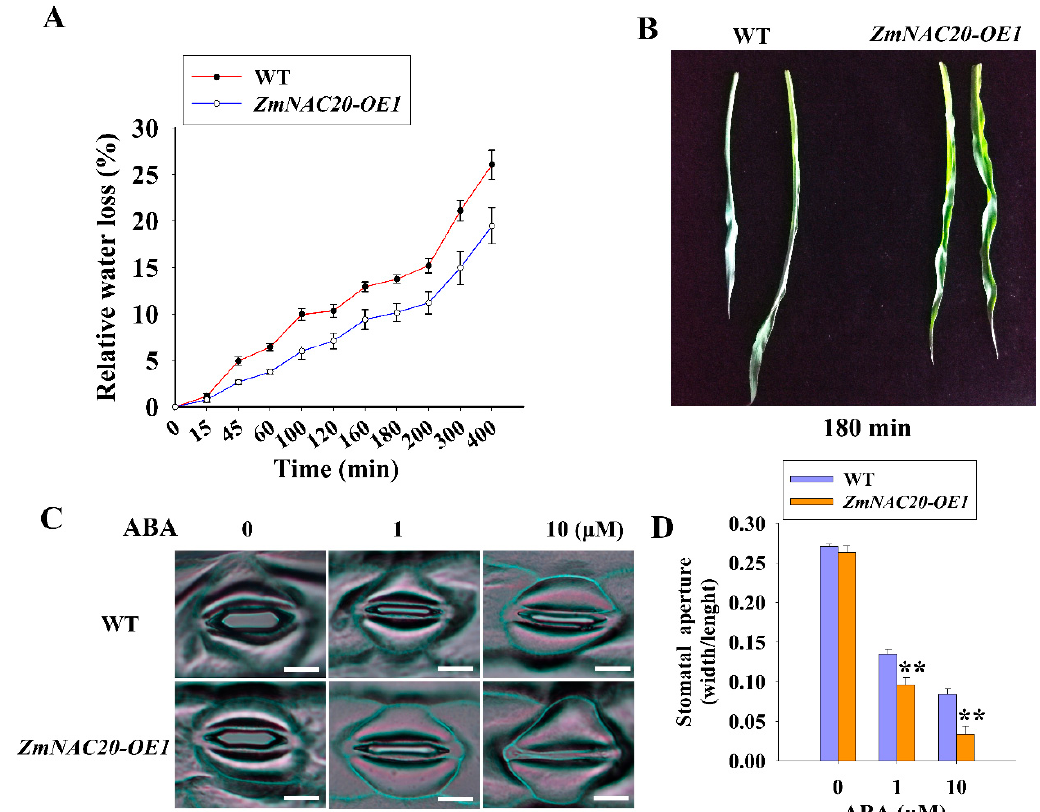
Figure 3. Stomatal aperture analyses of ZmNAC20 -overexpressing maize. ( A ) Statistics of relative water loss in detached leaves of WT and ZmNAC20-OE1 after dehydration for indicated times. WT represents the wild-type B104 inbred maize. ZmNAC20-OE1 represents ZmNAC20 -overexpressing transgenic maize. ( B ) Photograph of detached leaves after dehydration for 180 min. ( C ) Photograph of the stomatal aperture of detached leaves from WT and ZmNAC20-OE1 after ABA treatment. Bars, 10 μ m ( D ) Statistics of the stomatal aperture of detached leaves after ABA treatment. Asterisks indicate significant differences, ** p < 0.01 (Student’s t -test).